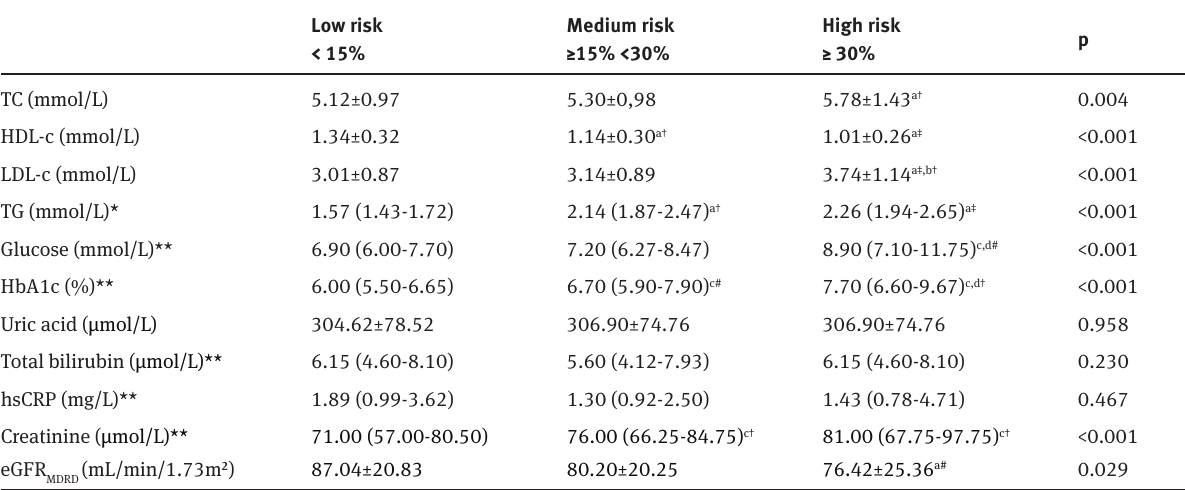
Table 2: Clinical parameters in diabetic patients according to CVD risk